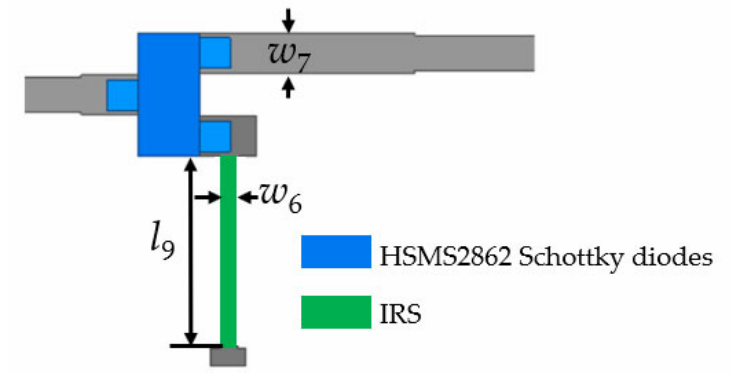
Figure 12. Configuration of the proposed IRS: l 9 = 4.4 mm; w 6 = 0.4 mm; w 7 = 0.9 mm.